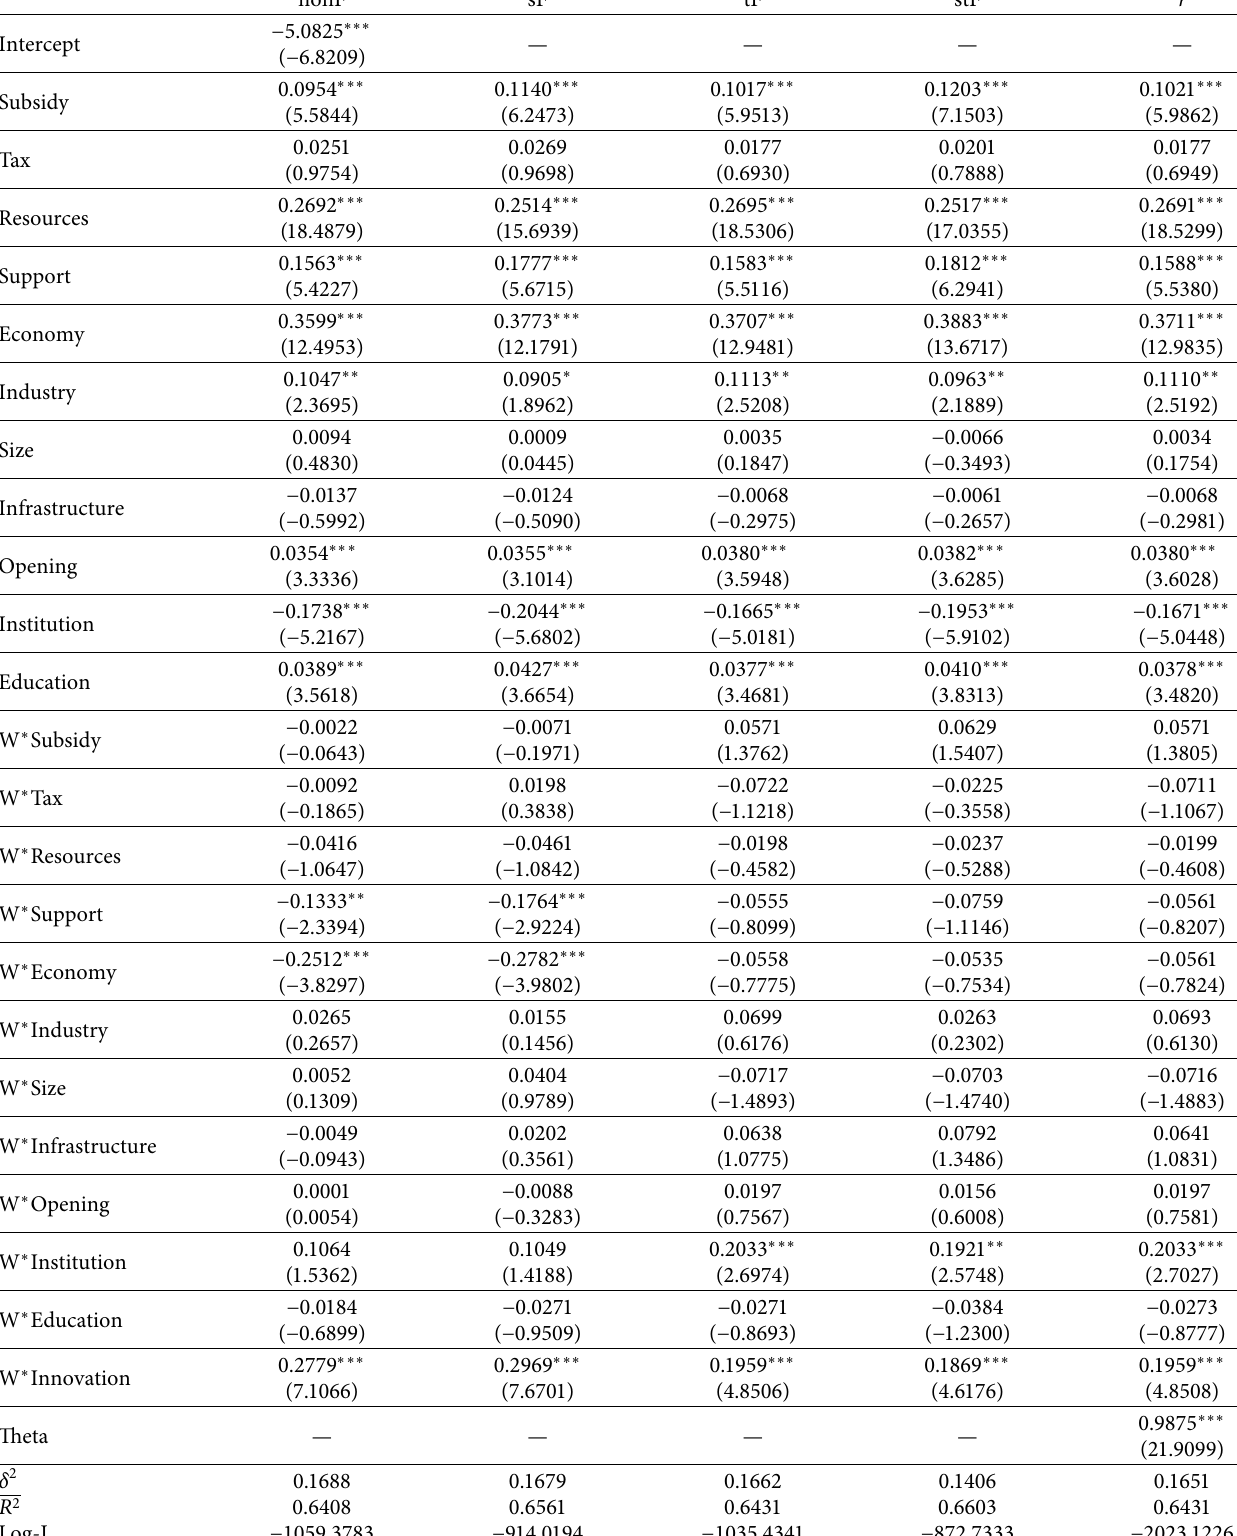
Table 4: Results of the spatial Durbin model